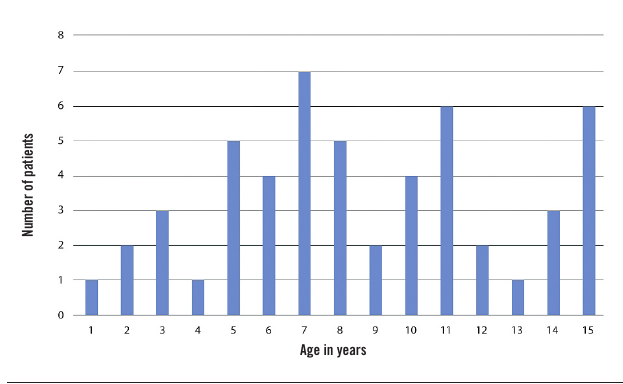
figurE − Distribution of patients with sickle cell anemia according to age